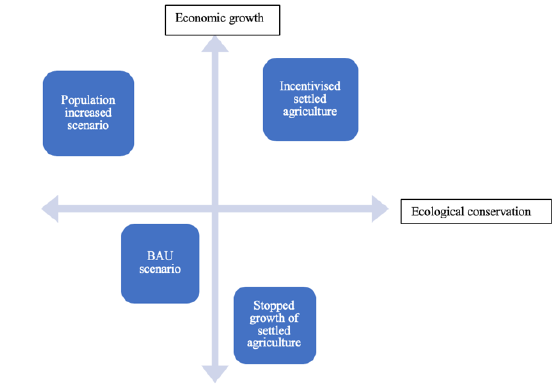
Figure 4. Economic growth vs ecological conservation quadrant The scenario where population is increased is placed in the second quadrant and can be seen as an economic growth which has raised the food consumption and demands. The increased demands however, put a huge stress on the environment and leads to exploitation of land.